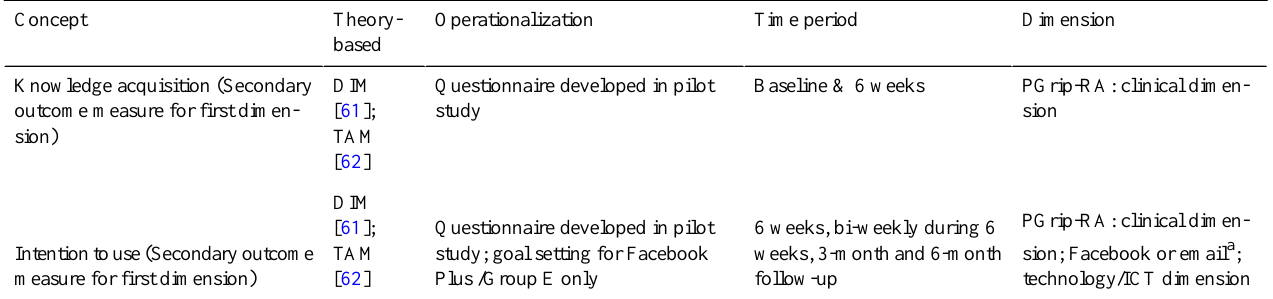
Table 3. Outcome measures according to selected measurement frameworks: KTA monitoring knowledge